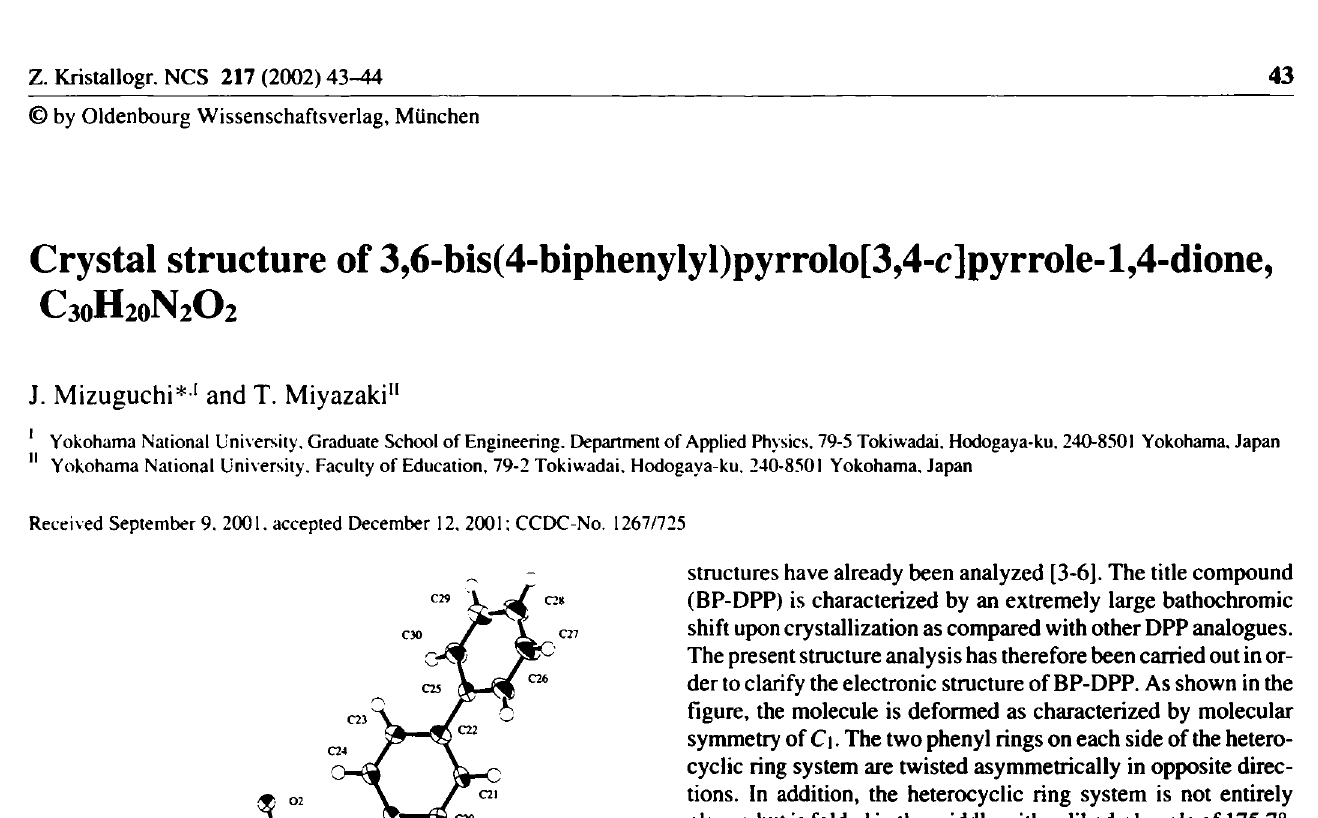
Table 1. Data collection and handling.